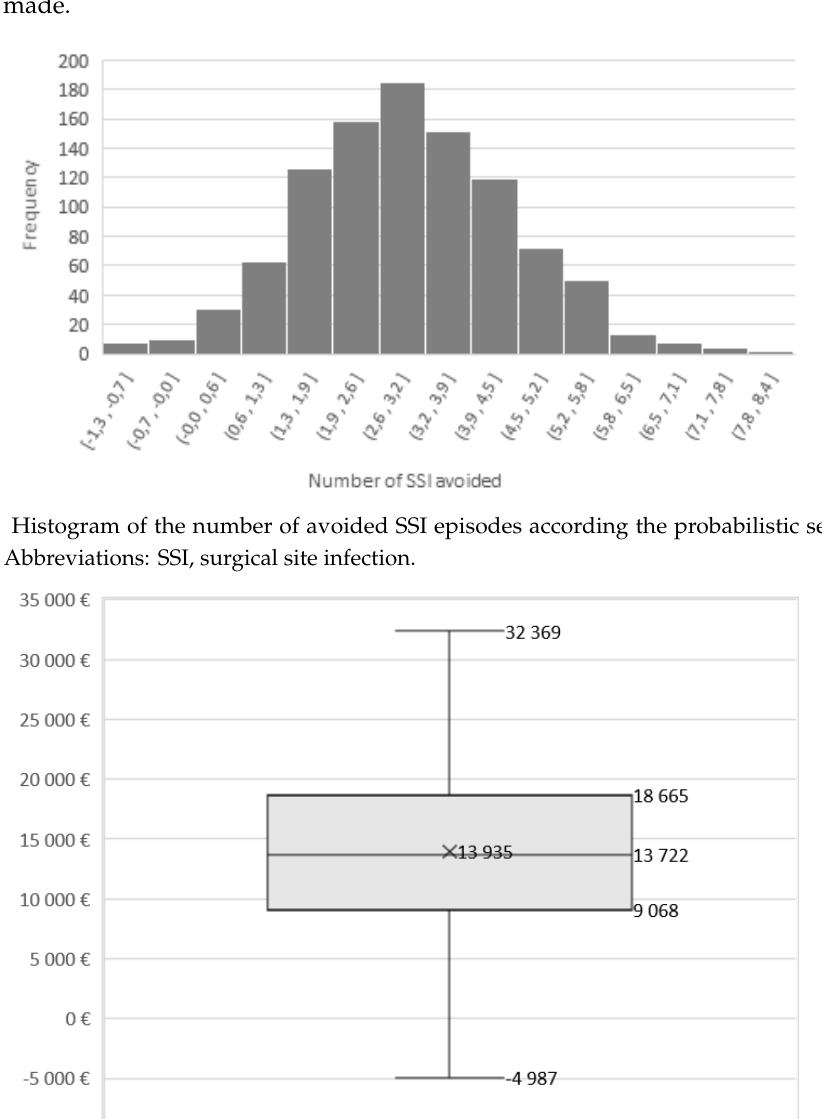
Figure 1. Tornado diagram with one-way sensitivity analysis results. Abbreviations: SSI, surgical site infection.